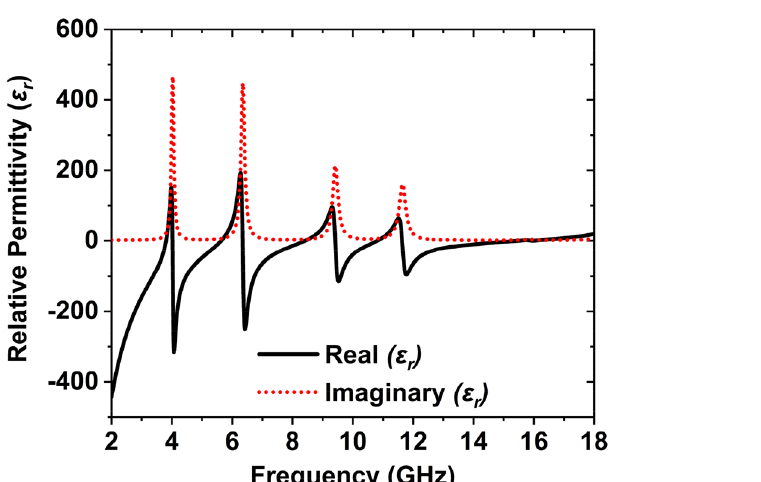
Figure 6. ( a ) Amplitude and ( b ) phase of the reflection response with co-and cross-polarized EM waves.